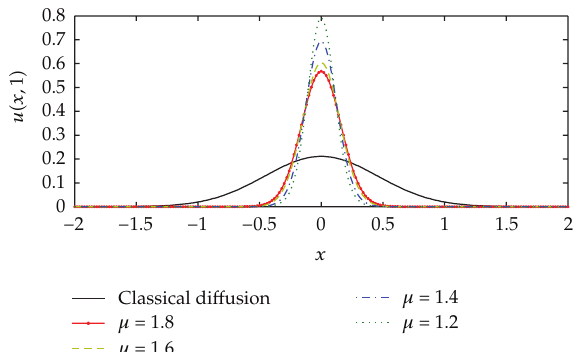
Figure 4: Numerical solutions at t (cid:8) 1 for (cid:3) 5.5 (cid:5) and (cid:3) 5.10 (cid:5) with λ (cid:8) 0 . 25.